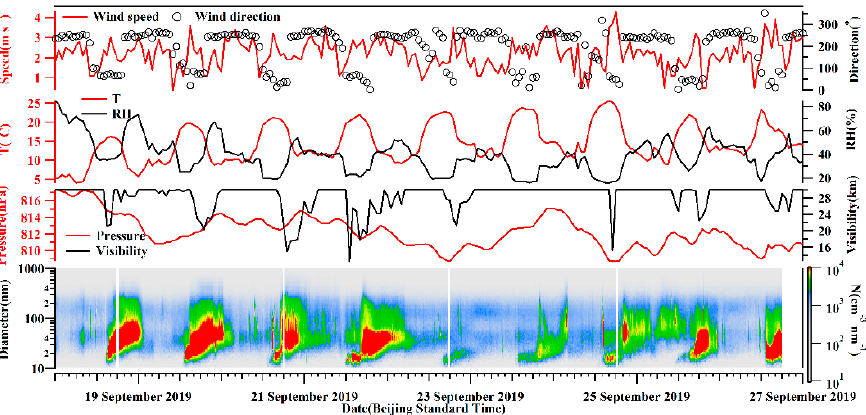
Figure 3. Time series of aerosol number concentration and meteorological elements near the ground observation.